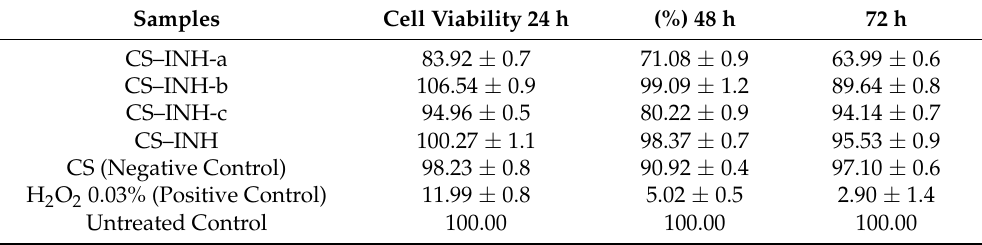
Table 3. The cell viability values (%) for the tested samples of powder compounds and microparticles after 24 h, 48 h and 72